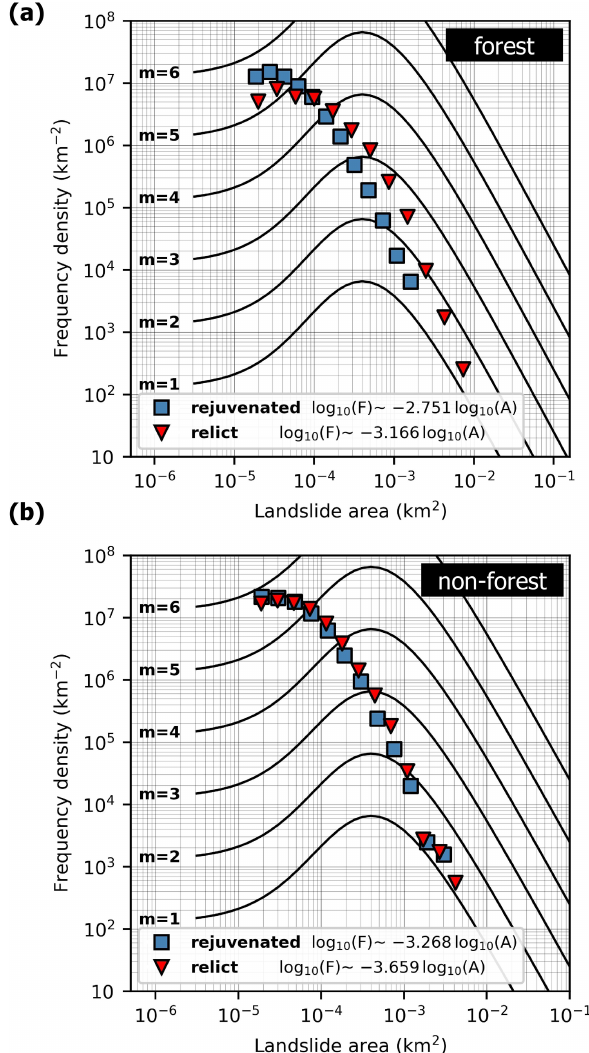
Figure 11. Frequency density as a function of the landslide source area. (a) The area frequency density of shallow landslides in for- est, separated for rejuvenated and relict landscapes. (b) The area frequency density of shallow landslides in non-forest, separated for rejuvenated and relict landscapes. There were not enough landslide observations in deforested land to fit their area frequency density to the inverse (cid:48) distribution. The general frequency density dis- tributions for inventories of different magnitudes (the black lines on the curves) are derived from Malamud et al. (2004). Note that the frequency is skewed towards smaller landslide sizes due to the omission of deep-seated (and generally larger) landslides from our